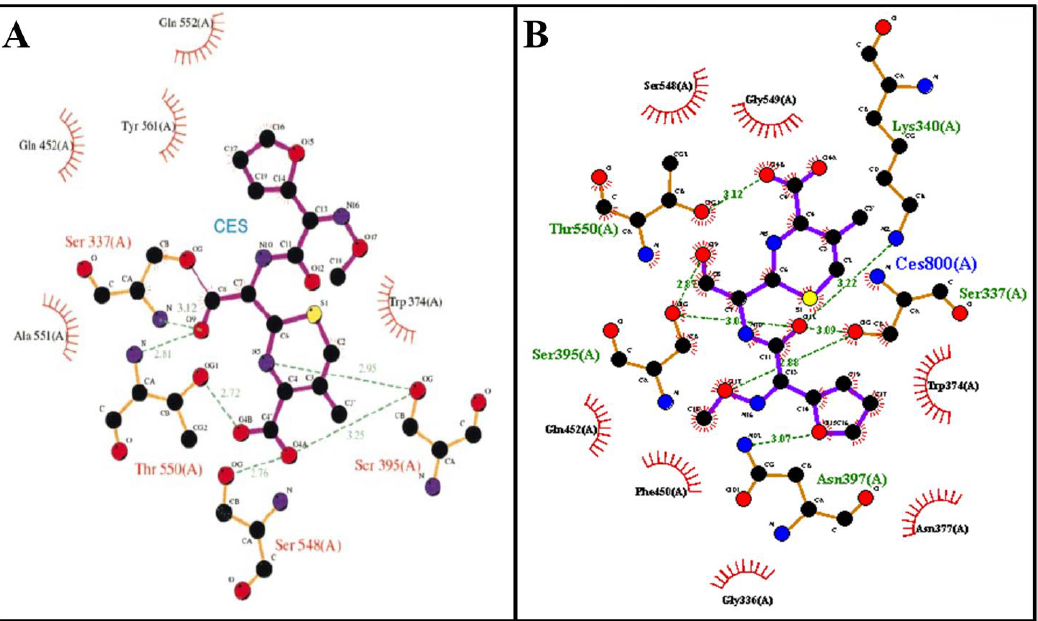
Figure 5. Binding mode of the cefuroxime ( A ) from literature and redocked ( B ). Adapted from Gordon, E et al., 2000 [25] .